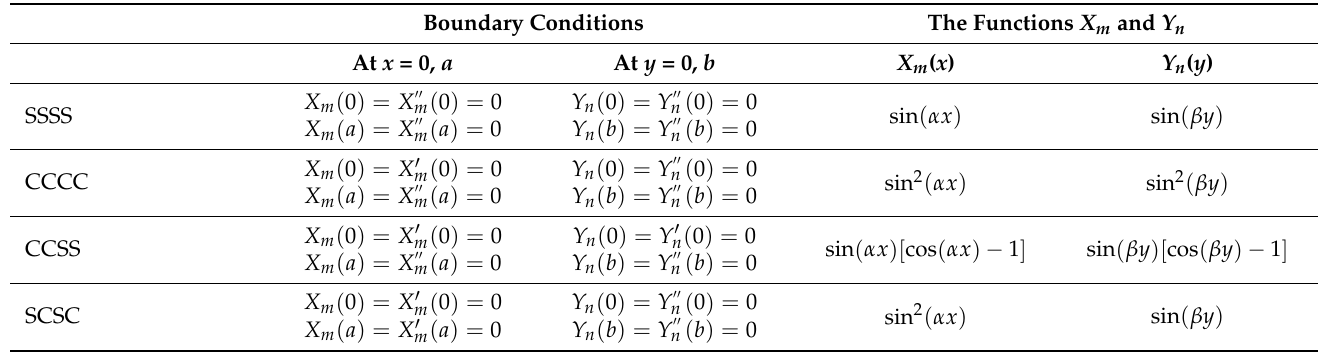
Table 2. The admissible functions X m ( x ) and Y n ( y ) for different boundary conditions. Boundary Conditions The Functions X m and Y